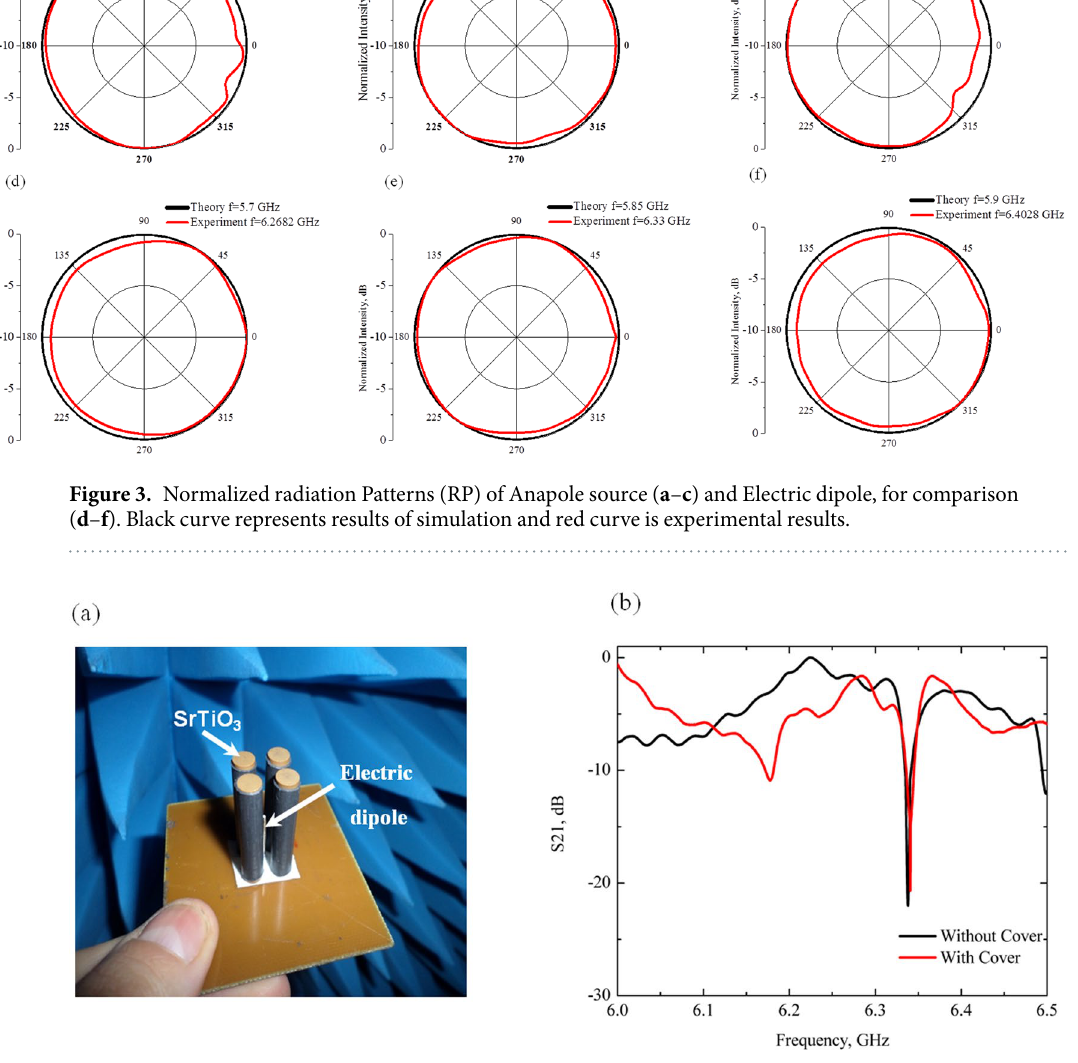
Figure 4. ( а ) Experimental sample of the nontrivial nonradiating all-dielectric anapole based on four- SrTiO 3 cylinders with diameter 5 mm, excited by electric dipole antenna in the center of meta-molecule. ( b ) The experimental spectra S21 of power received at second antenna relative to the power input to the source: without and with metallic plate on the top of the source, where the black curve corresponds to the case without metallic plate and the red curve is for covered open end of the source by metal